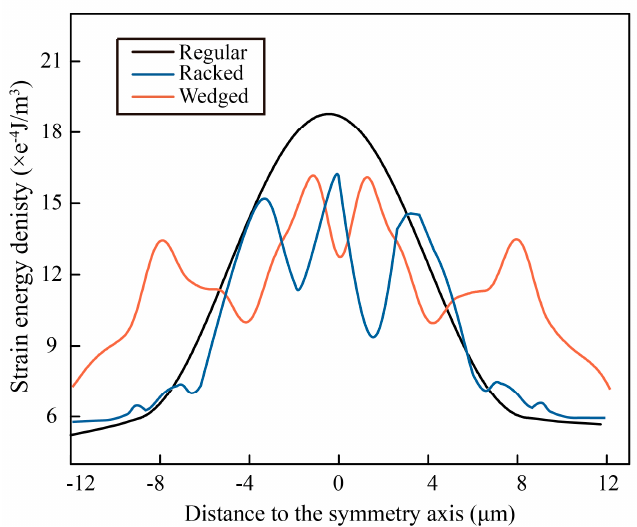
Figure 9. Strain energy density in various morphological models.